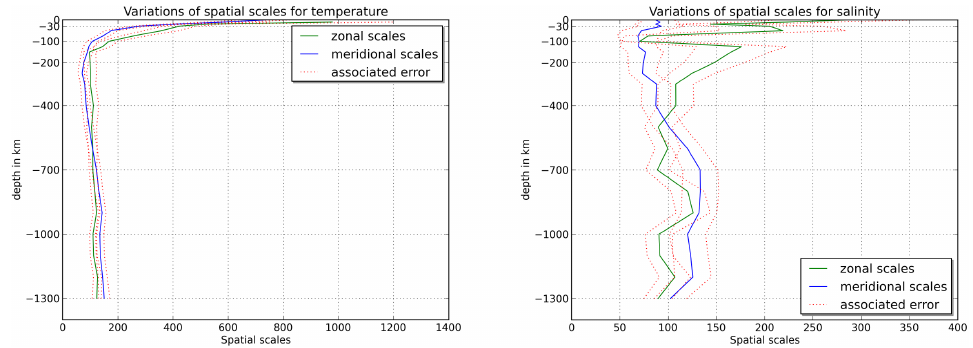
Figure 9. Variations of zonal and meridional spatial scales for temperature (left) and salinity (right) according to depth for box 2 (midlatitude North Atlantic). Dotted lines represent standard fitting